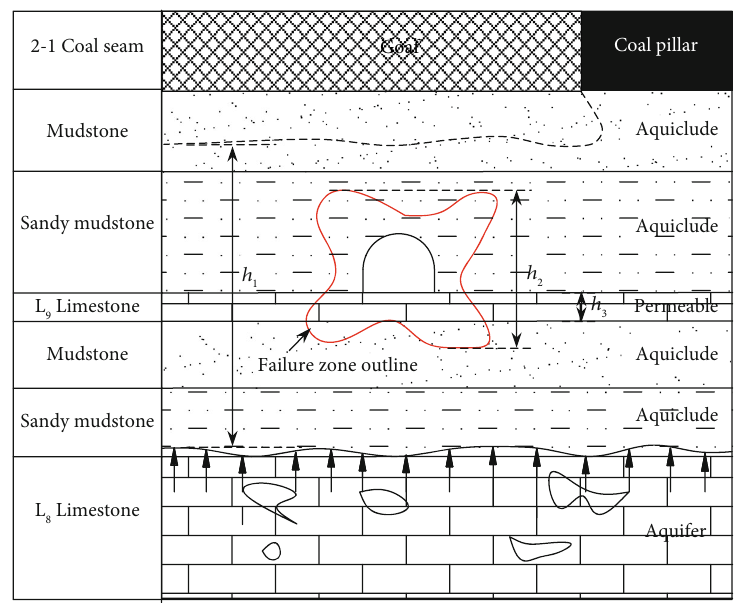
Figure 9: The in fl uence of surrounding rock disturbance on the thickness of aquifers.